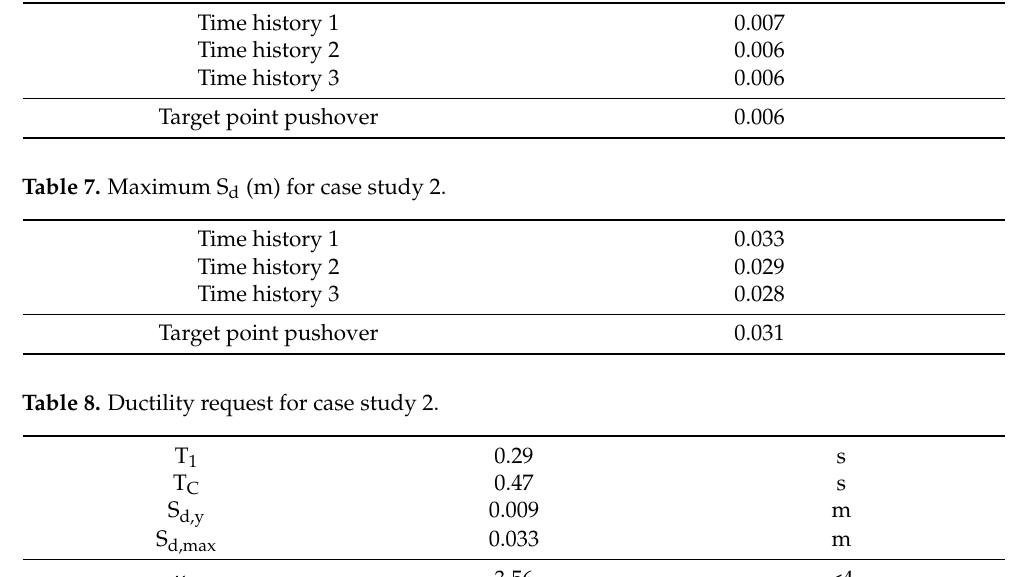
Figure 13. Hysteresis cycles obtained from the dynamic time-history analysis for case study 1. Table 6. Maximum S d (m) for case study 1.